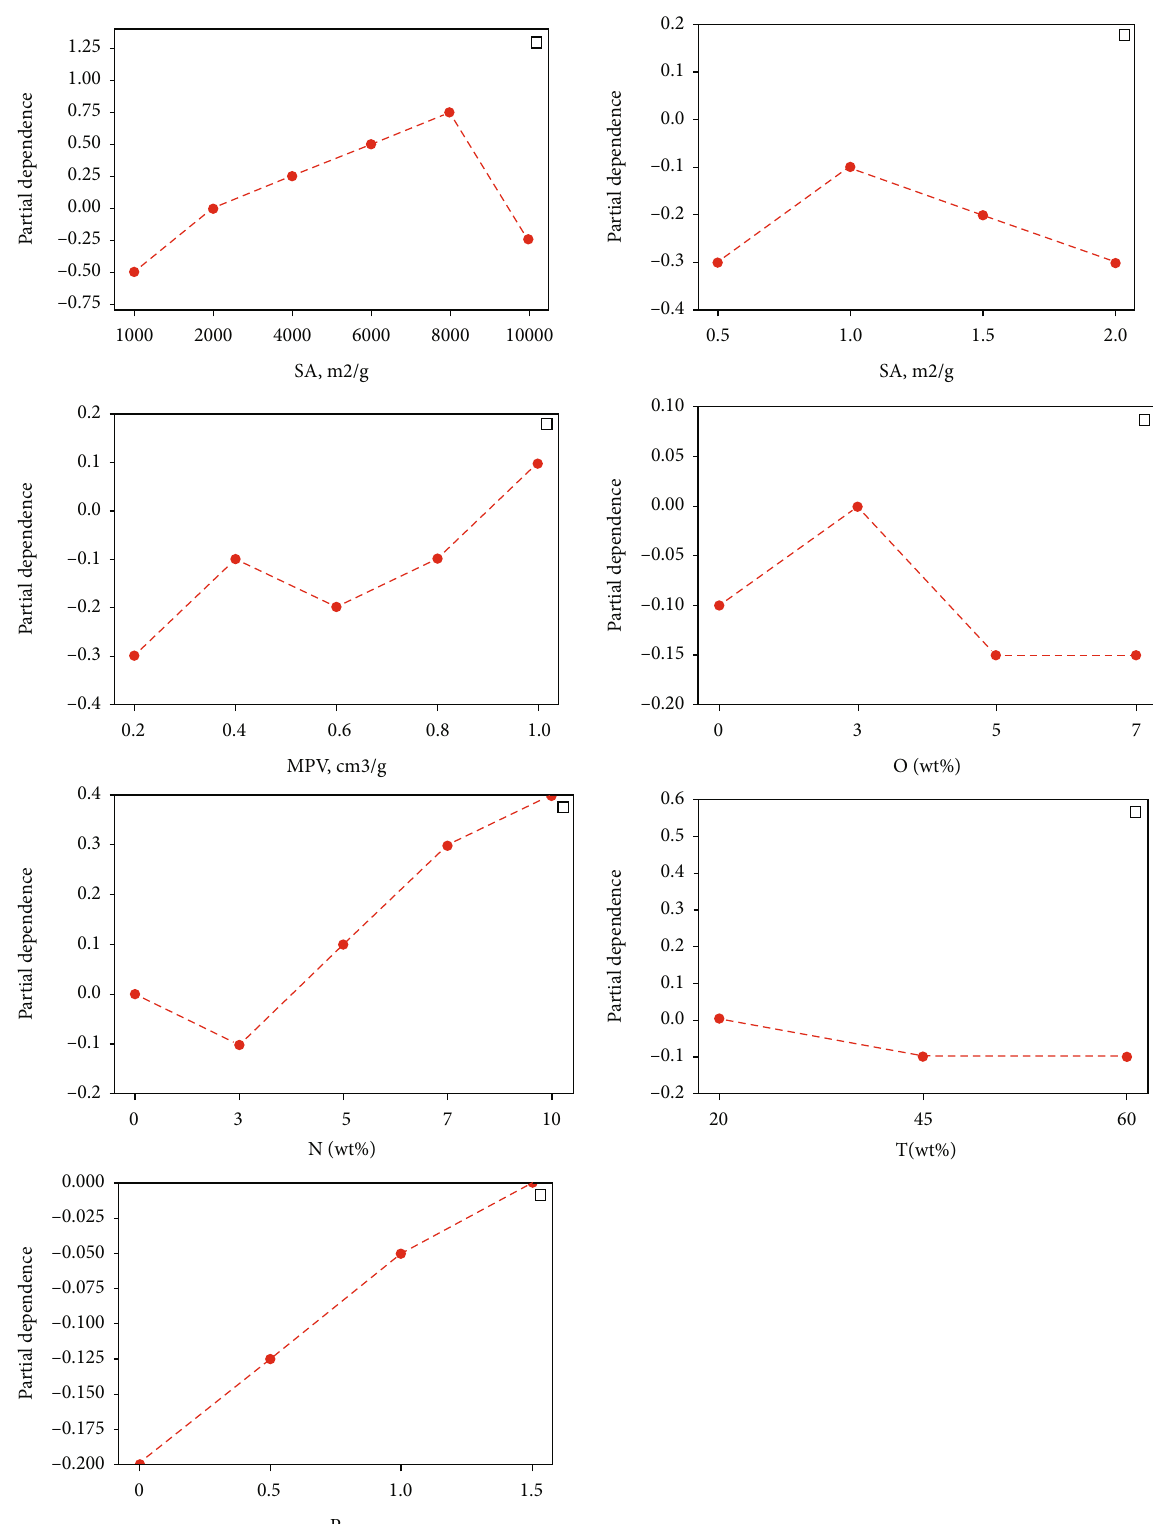
Figure 2: Input features of adsorption of CO